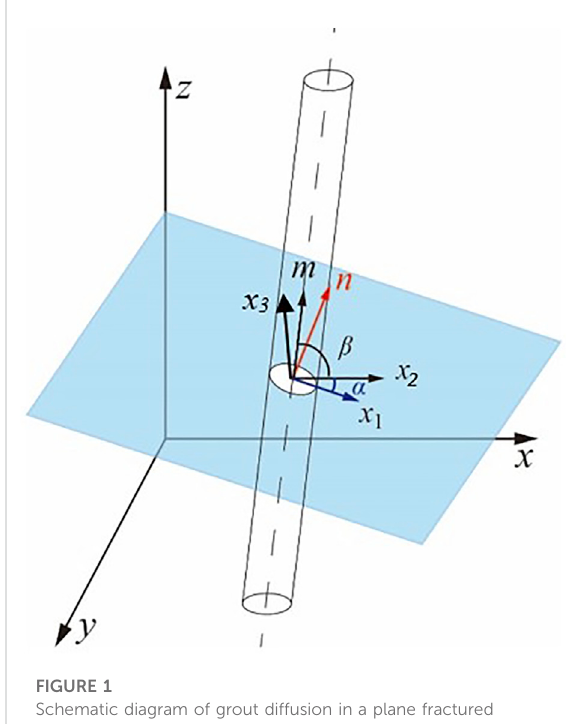
FIGURE 1 Schematic diagram of grout diffusion in a plane fractured rock